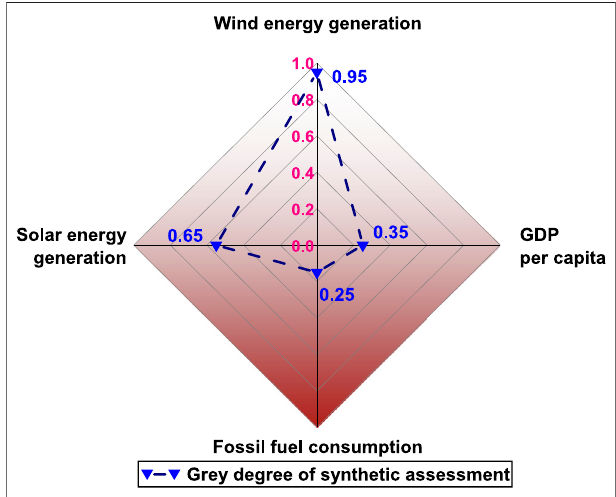
FIGURE 9 | The G-TOPSIS